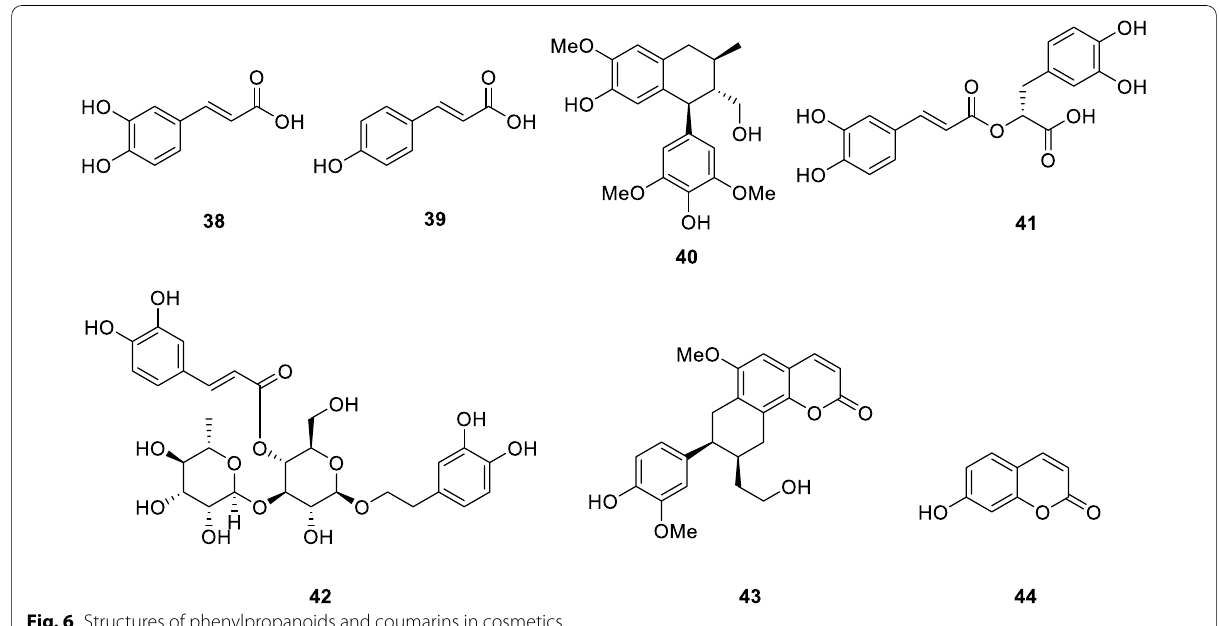
Fig. 6 Structures of phenylpropanoids and coumarins in